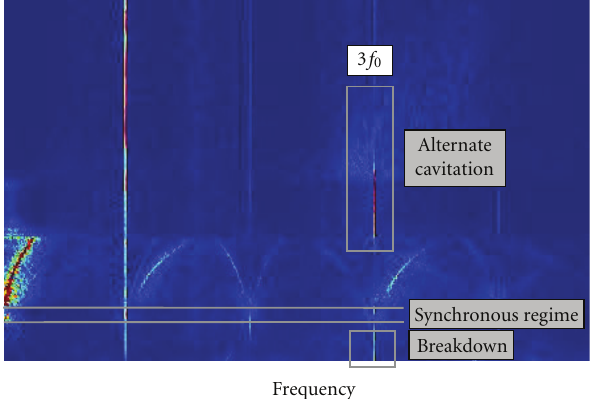
Figure 13: Extended waterfall plot of F y (1.18 Q n , N ref